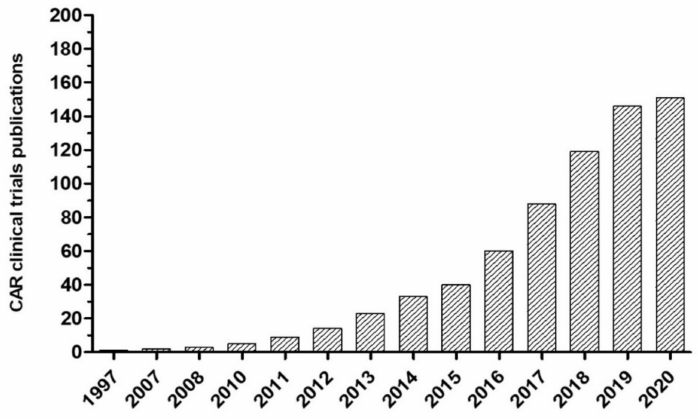
Figure 1. Cumulative publications of chimeric antigen receptor (CAR) immunotherapy in clinical